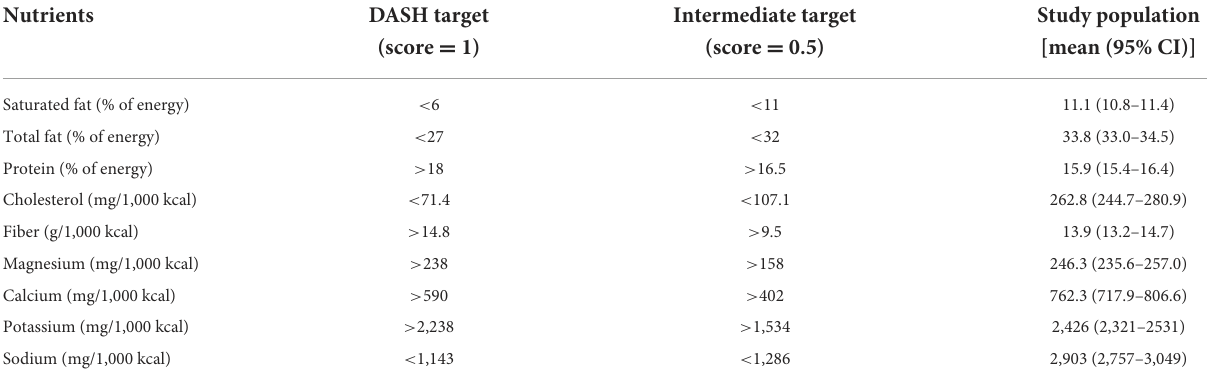
TABLE 1 Nutrients target for DASH score and nutrients intake of the study